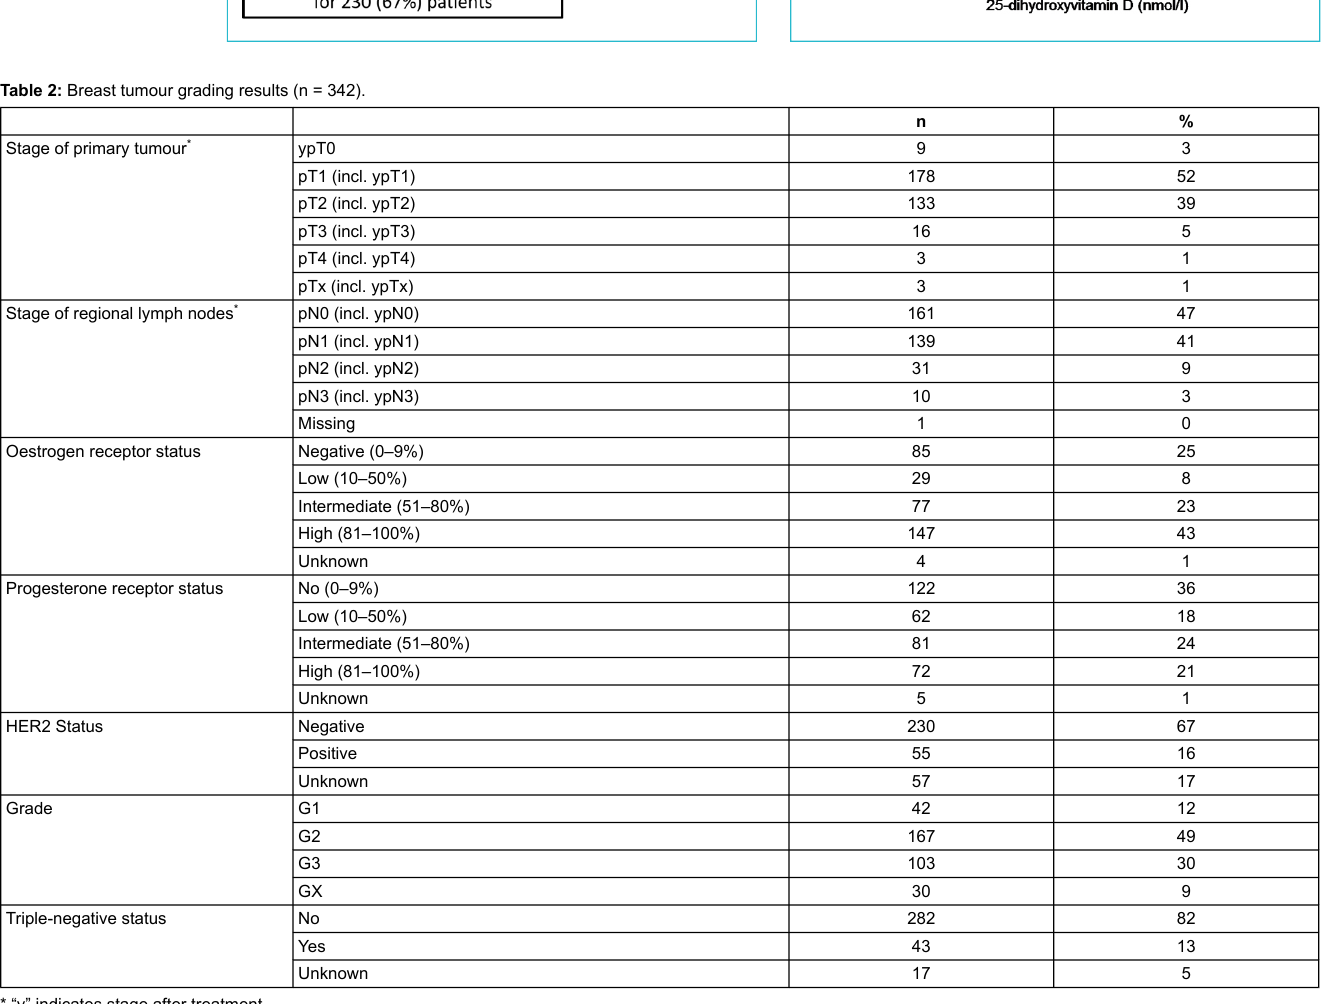
Table 2: Breast tumour grading results (n = 342).